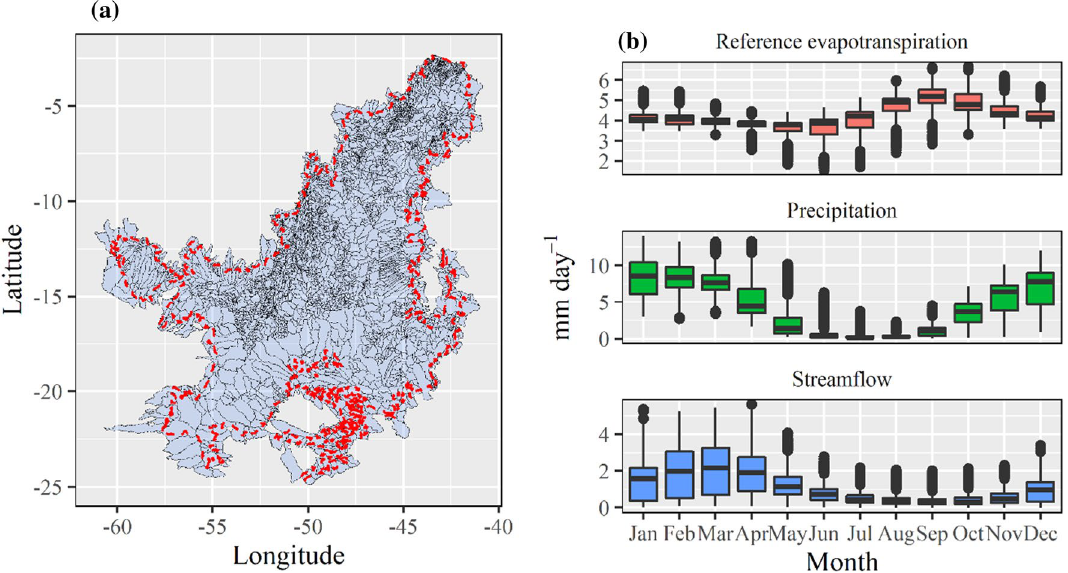
Fig. 2 a Boundaries of all level 5 ottobasins in the Cerrado and b their respective mean monthly reference evapotranspiration, precipitation, and